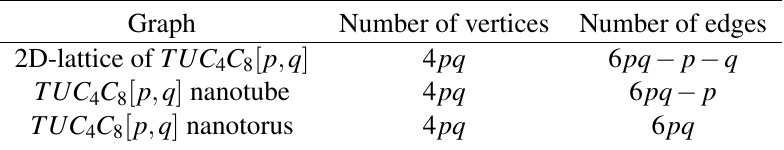
Table 2 Number of vertices and edges.